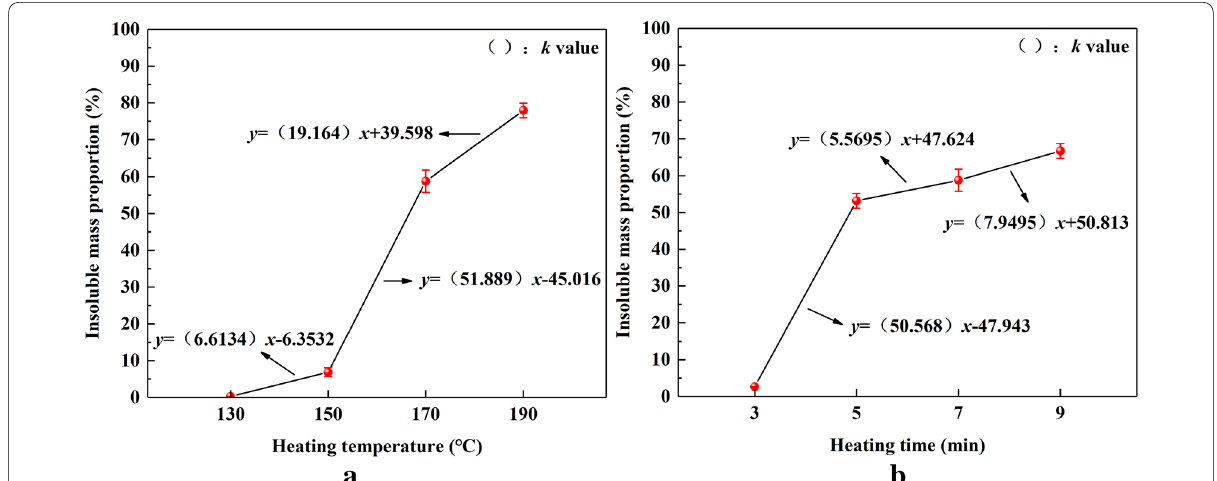
Fig. 5 Effects of a heating temperature and b heating time on the insoluble mass proportion of EHADP adhesive